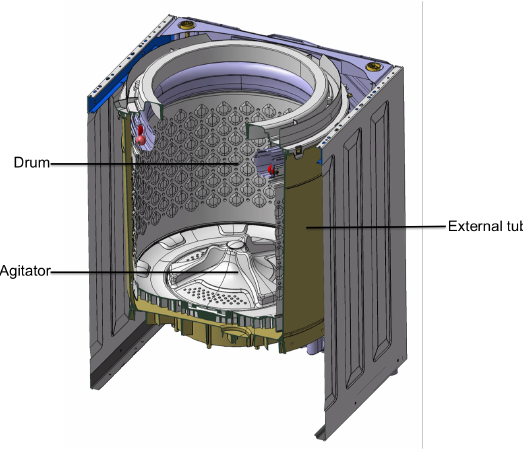
Figure 3. Vertical axis washing machine structure: Image provided by Electrolux.